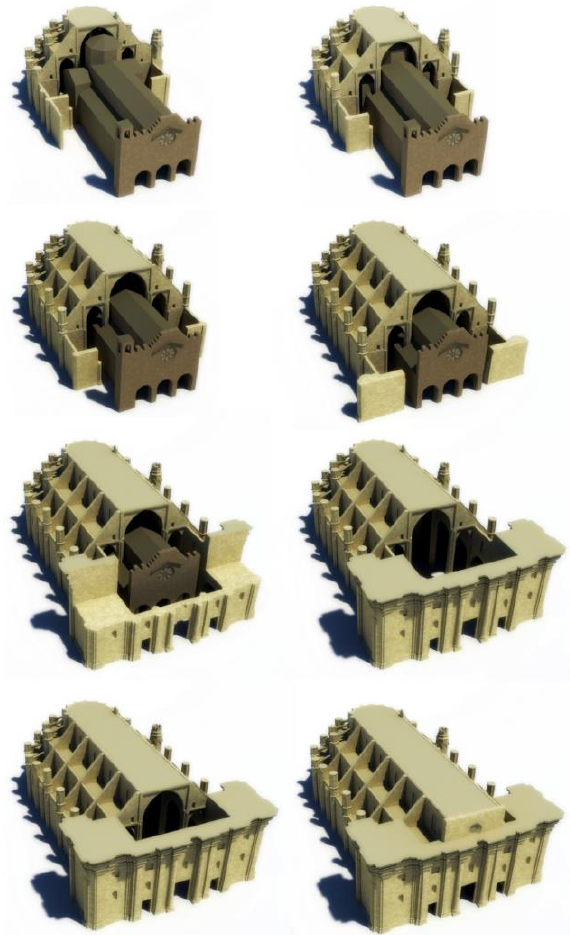
Figure 1. Construction phases of Tortosa’s Cathedral’s central body